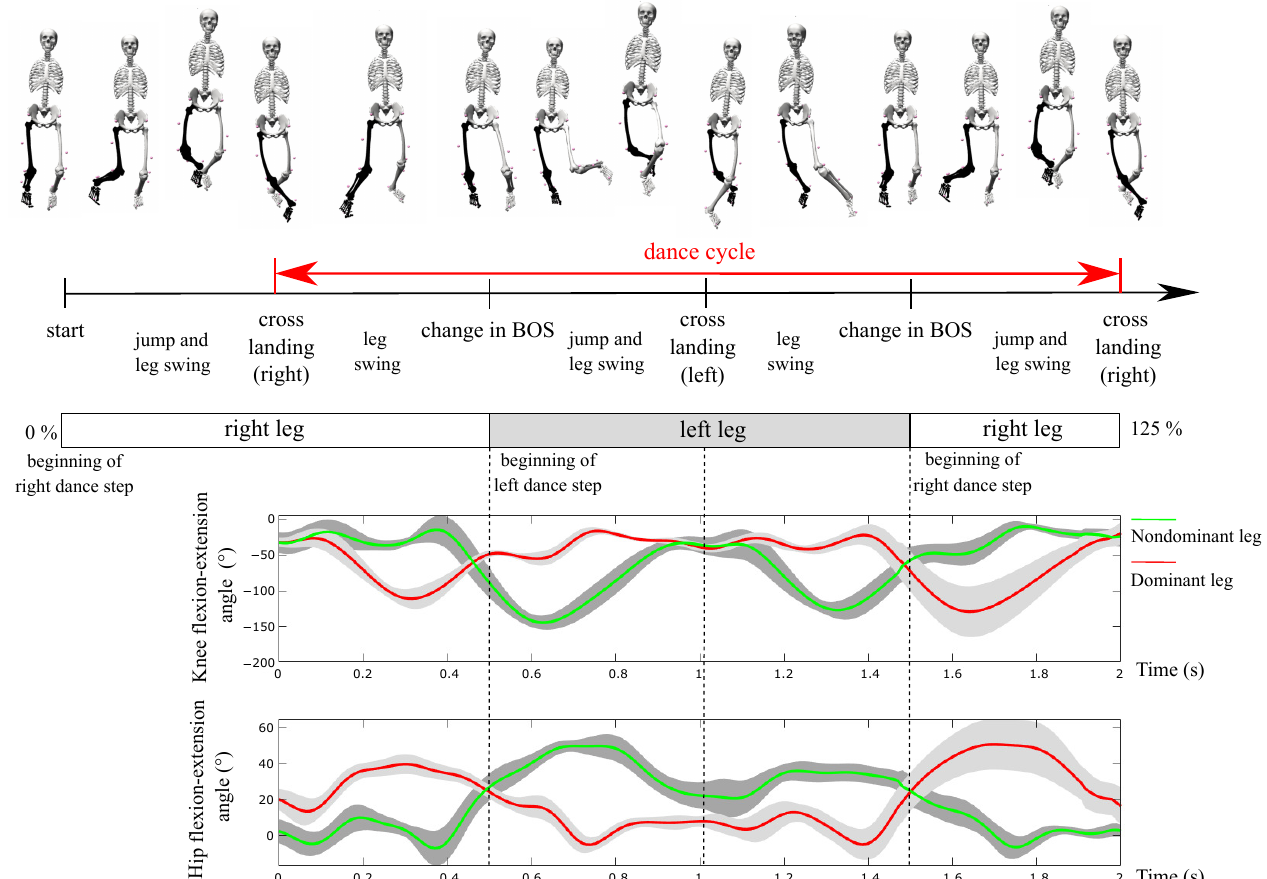
Figure 1. The examined motion of the “Kalocsai mars” dance: one dance step consists of one right and left leg repetition. The figure also shows the definition of a dance cycle, which can be used to analyze the angular and kinetic parameters of the lower extremities. Below, the average and the standard deviation of knee flexion angle and hip flexion angle are also represented. The dominant leg, for the subject shown in the figure, was the right leg. The perspective might be distorted. Table 1. Examined biomechanical parameters calculated from the markers’ coordinates and the captured ground reac- tion forces.